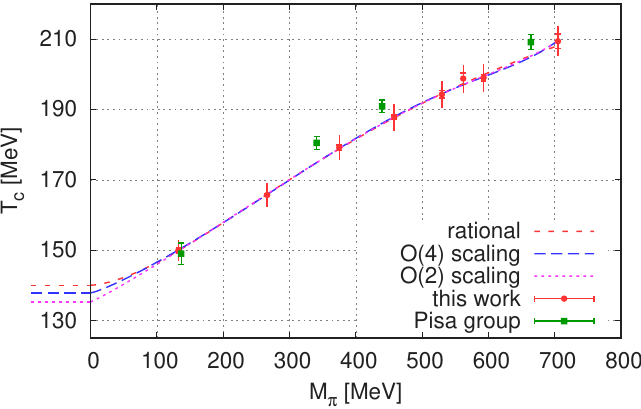
Figure 3 . The pseudo-critical trajectory, together with the results of (cid:12)ts performed according to eqs. (4.1) and (4.2). The extended error bars include the systematic e(cid:11)ect due to scale setting. Data from ref. [13] are also included for